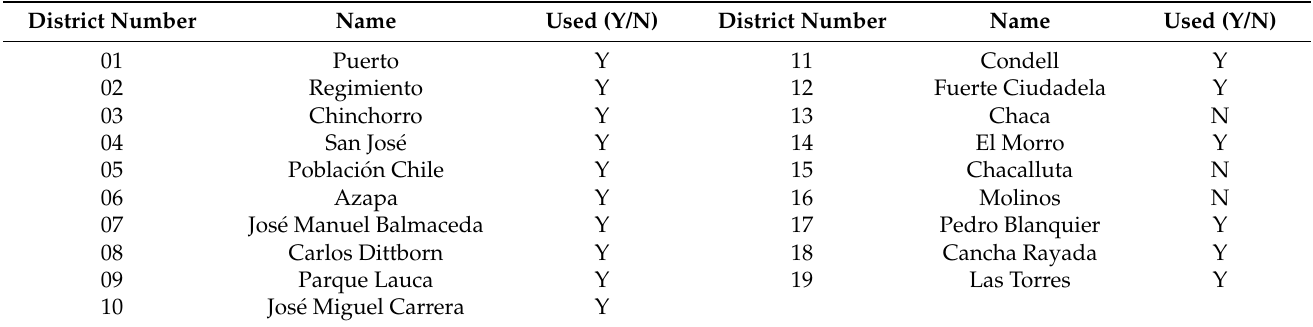
Table 2. Arica census